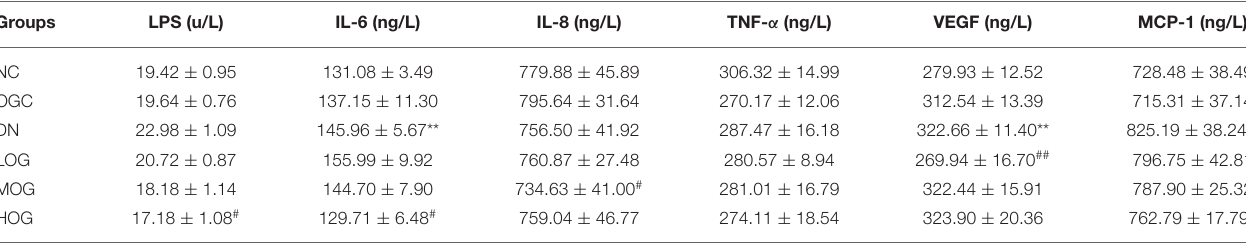
TABLE 2 | Serum levels of inflammatory factors of the rats in each group ( n = 10).